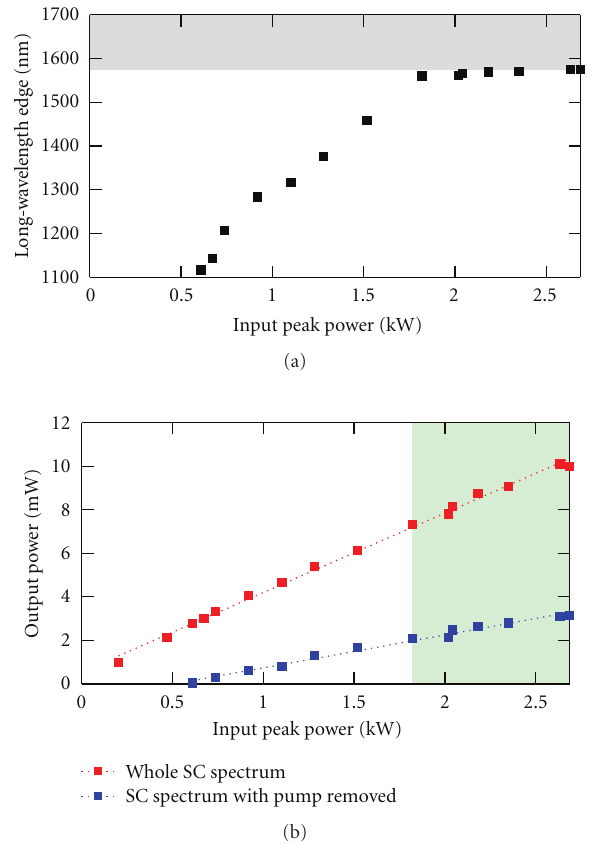
Figure 10: (a) Measurement of the long-wavelength edge of the SC spectrum as a function of input peak power in a 10 m-long solid- core PBG fiber sample. The gray area depicts the region outside the first PBG transmission window. (b) Measured output average power over the whole SC spectrum (red squares) and by removing the output pump peak with a 1064 nm notch filter (blue squares), as a function of input peak power. Dotted lines are linear fits. The green area corresponds to input peak powers for which the SC spectral extent stops (i.e., for input peak powers greater than 1.8